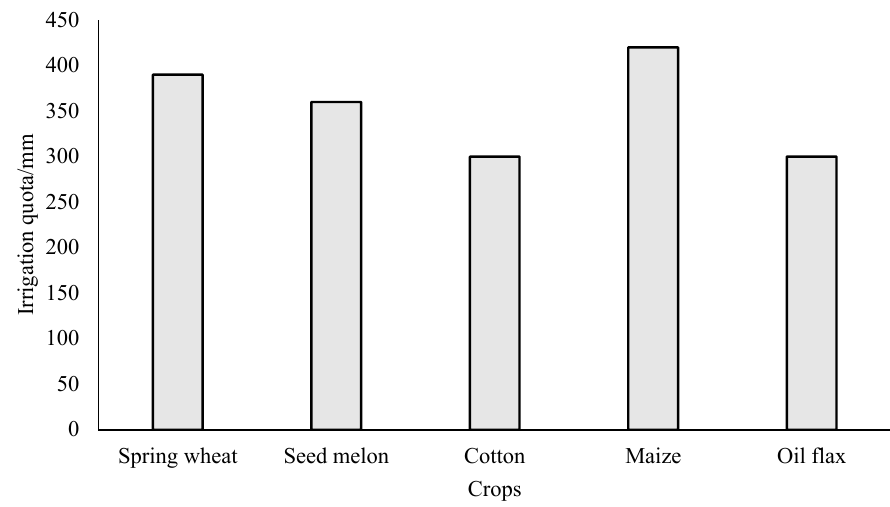
Figure 5. Current irrigation quotas of typical crops in Minqin County.